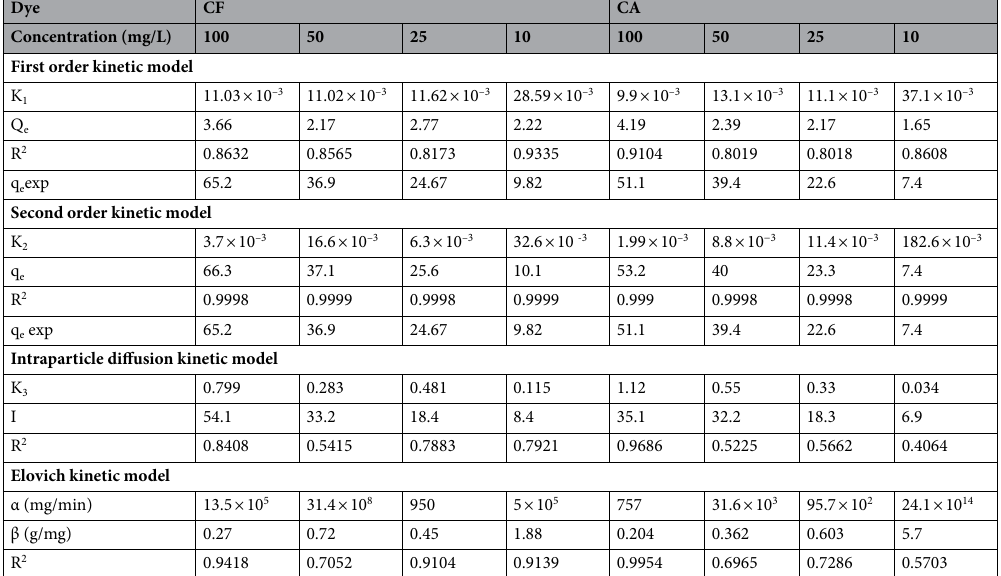
Table 3. Parameters of the kinetic models for disperse red 60 adsorption on CF and CA.